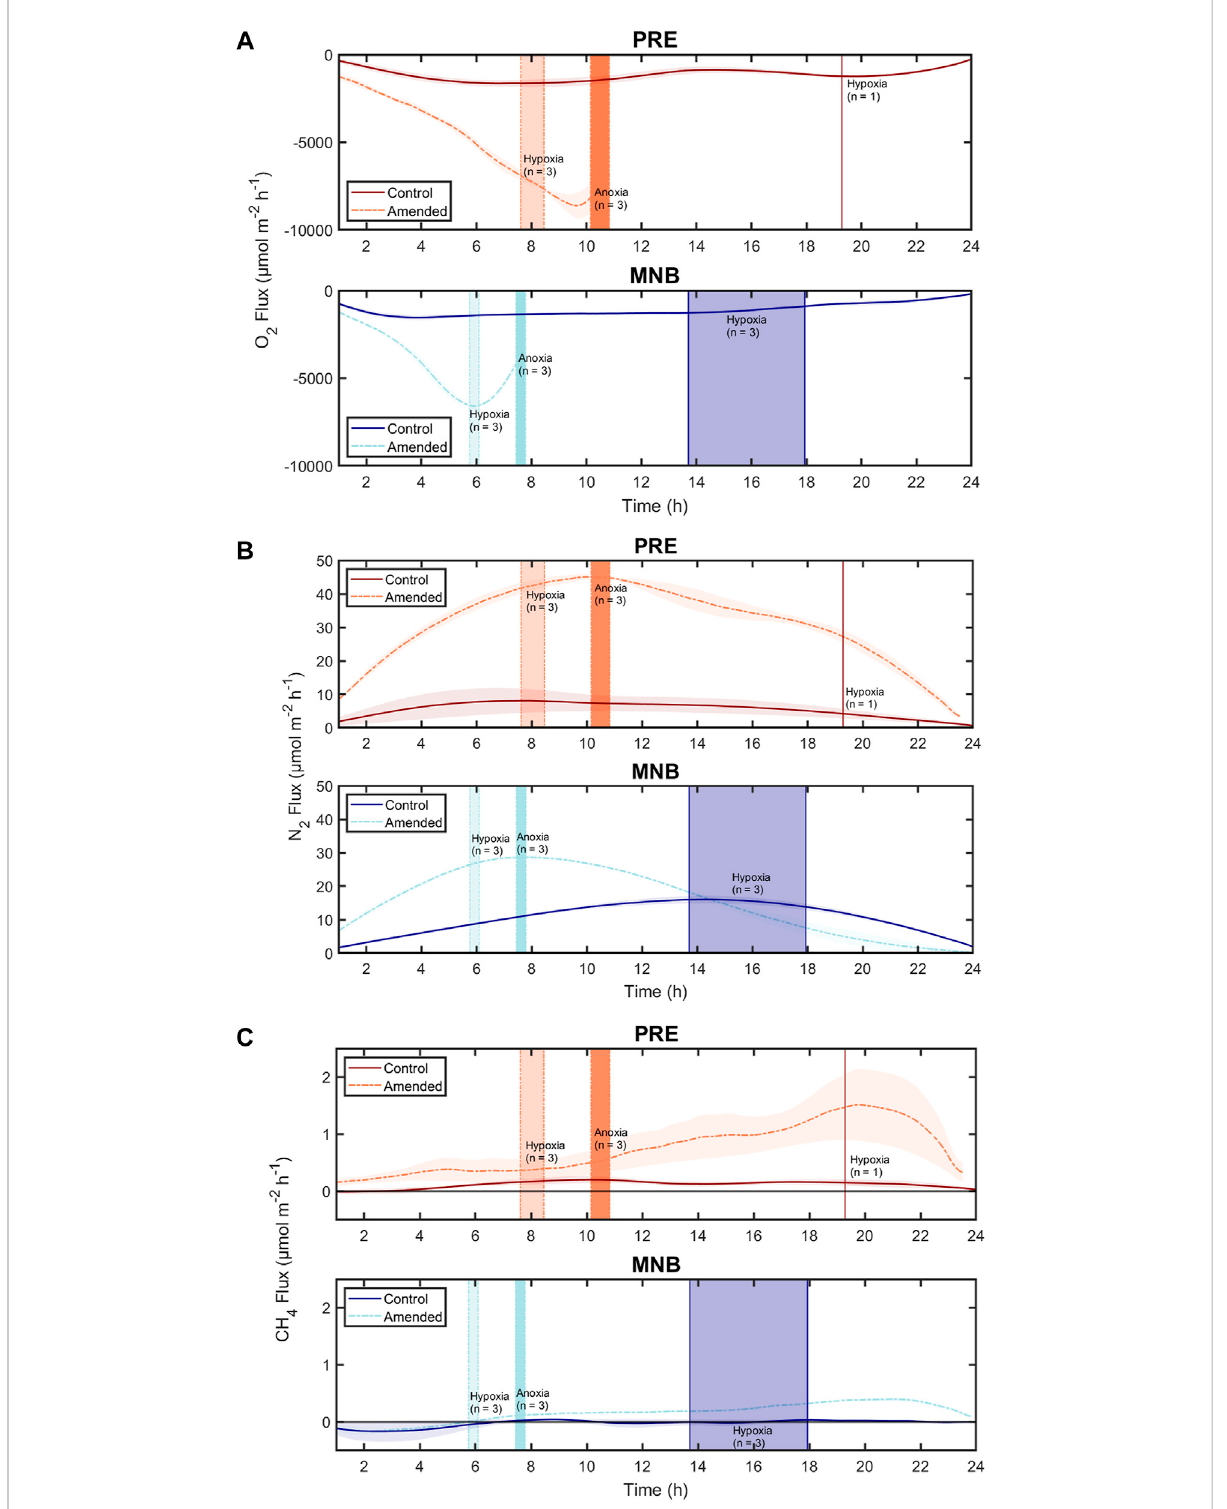
FIGURE 3 Variationof fl uxesof (A) oxygen(O 2 ), (B) dinitrogen(N 2 ),and (C) methane(CH 4 )fromsedimentsincubatedover24 h.Sedimentswerecollected either from a more nutrient-enriched and productive site (Providence River Estuary, PRE) or a less productive site (Mid-Narragansett Bay, MNB) and incubated under ambient conditions (control) or treated with an initial pulse of organic matter (amended). Curve shading around the continuous